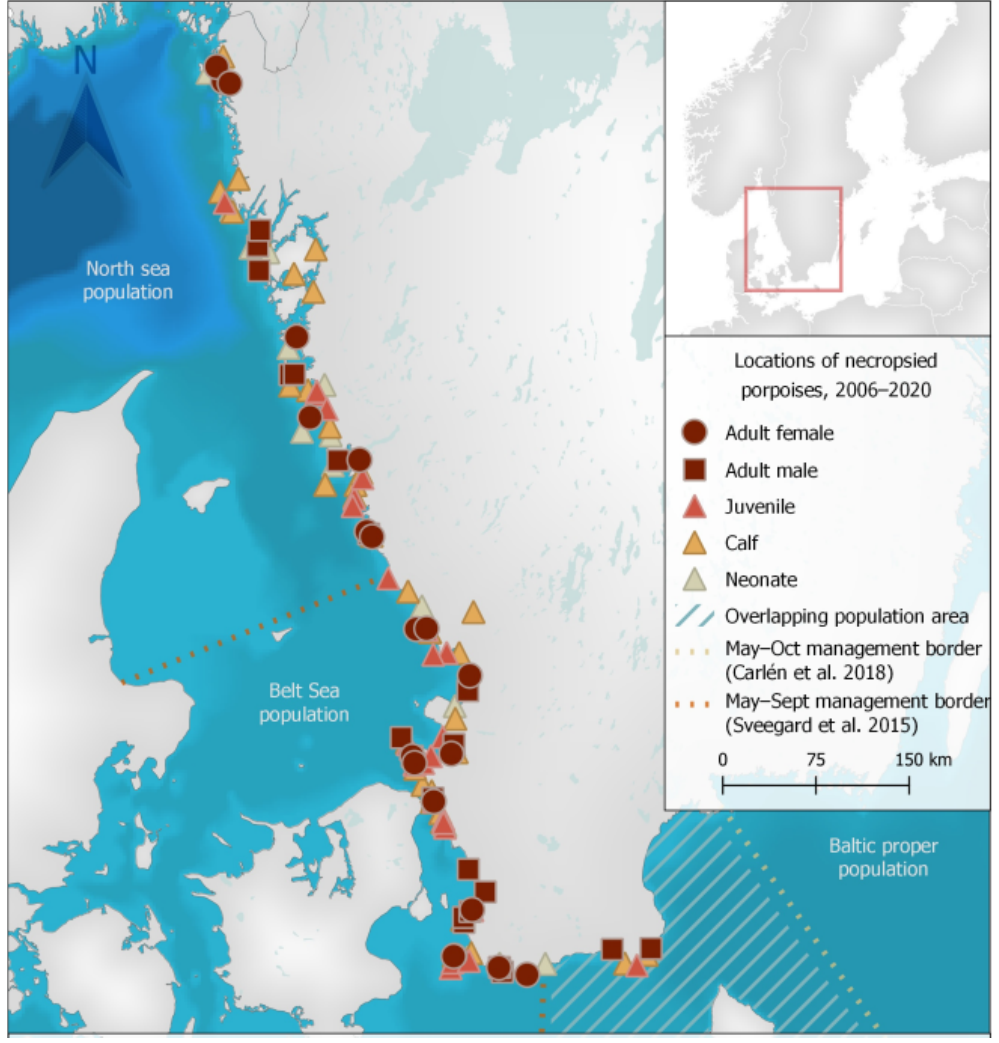
Figure 1. Locations of stranded harbour porpoises ( Phocoena phocoena ) collected from 2006 to 2020 in Sweden for post-mortem examination. Geodata: Carl é n et al. [20], HELCOM (Open Street Map) [21], Siefert et al. [22], Sveegard et al. [23], Lantmäteriet (Sverigekartan) [24]. Of the 128 porpoises examined, 64 were females, 63 were males and sex could not be determined in one animal with missing tissues. There were 21 neonates (16.4%), 40 calves (31.3%), 26 juveniles (20.3%) and 41 adults (32%). Porpoises were found during all months a larger peak from July to September (Figure 2). Almost two thirds (63%) of adults were two neonates were found May 24 and September 4, respectively. Detailed data for each animal is presented in Table